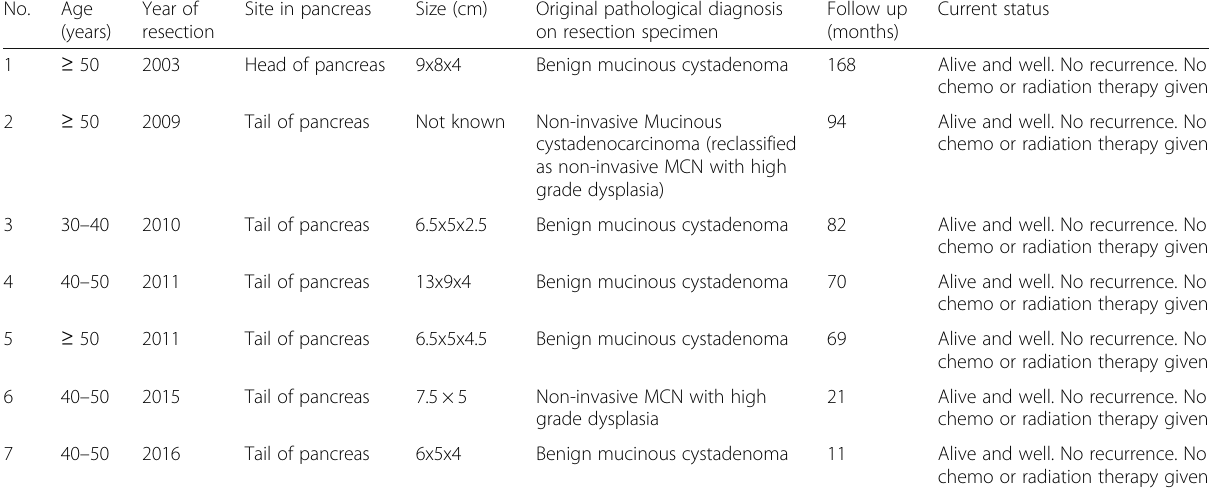
Table 1 Follow up information in our series ( n =